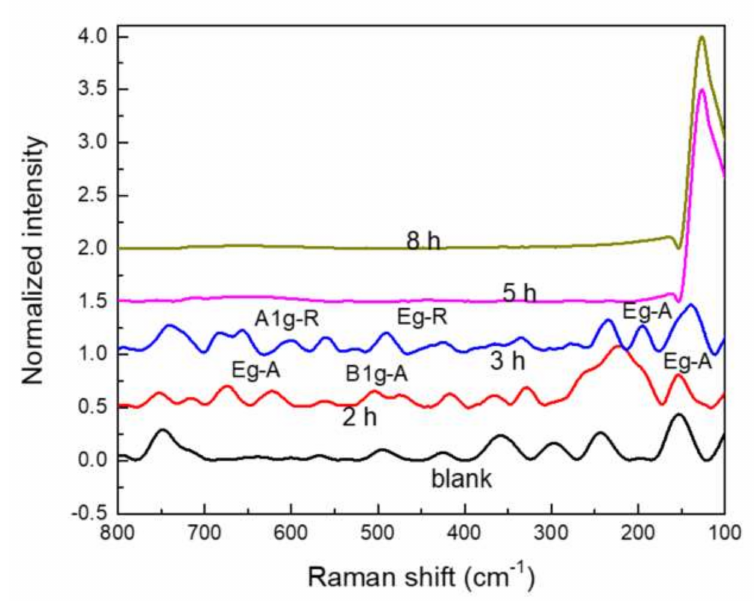
Figure 2. Raman spectra for Ti6Al4V alloy oxidized at different times.